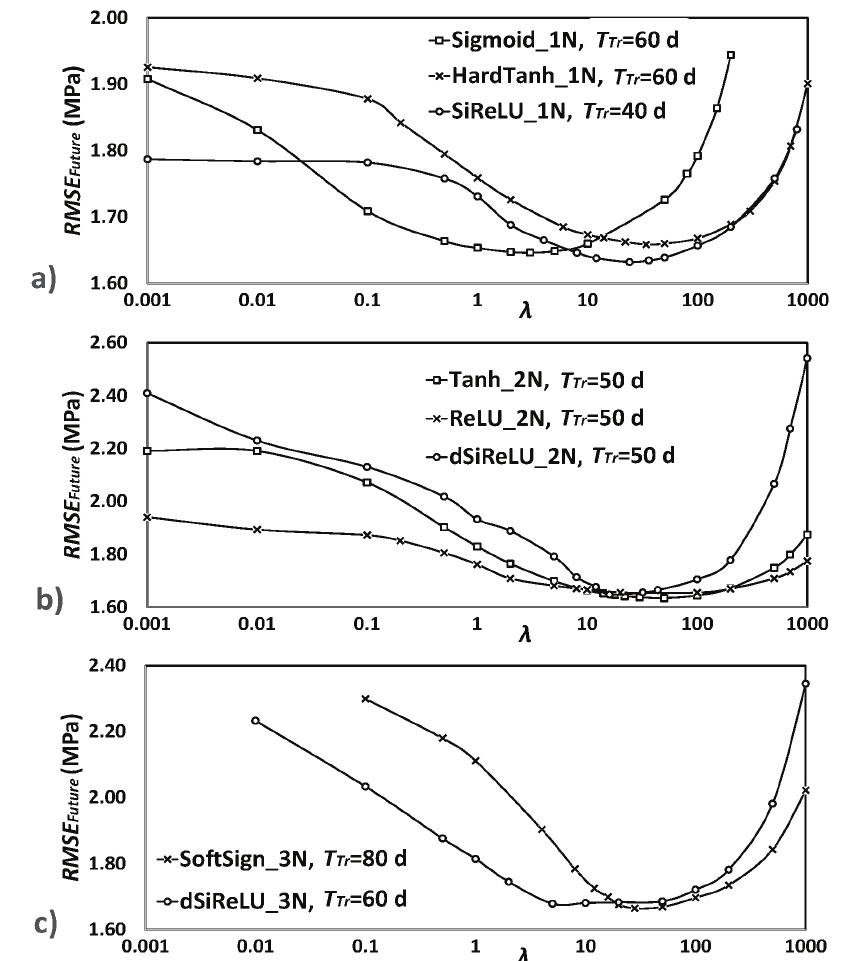
for various AFs and ANNs with a) one node, b) two nodes, and c) three nodes in the Fig. 9 – Impact of λ-multiplier on RMSE Future hidden layer, for